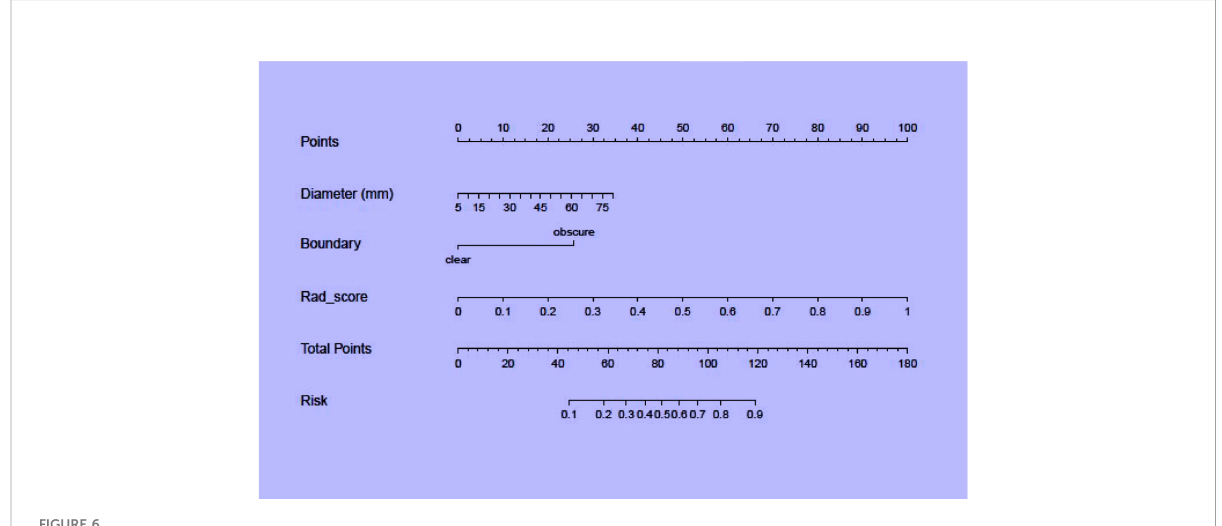
FIGURE 6 A combined radiomics nomogram for predicting thymomas risk